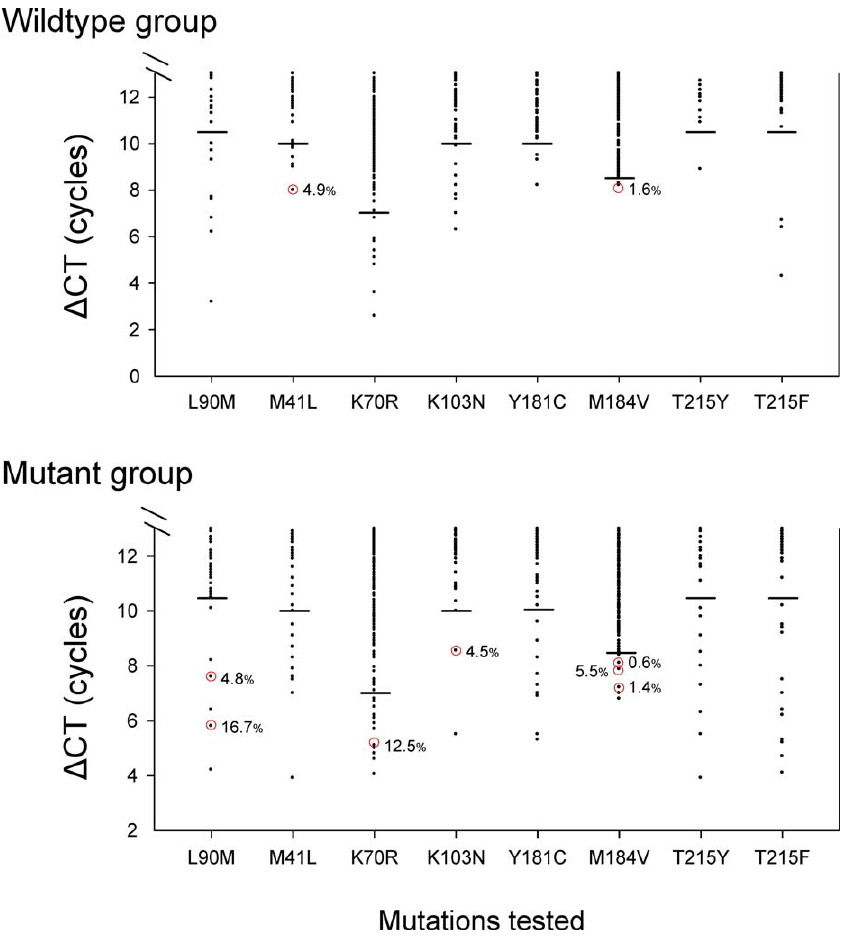
Figure 3. Real-Time PCR Mutation Test Results ( D CT) for the Cross-Sectional Group The samples positive for minority resistance are emphasized ( D CT results above 13 cycles are not shown). The wild-type and mutant groups were tested for eight key resistance mutations. Horizontal bar (—) denotes the assay cutoff for the mutation. Samples falling below this bar are positive for the mutation. The clonal frequencies are shown for encircled data points.